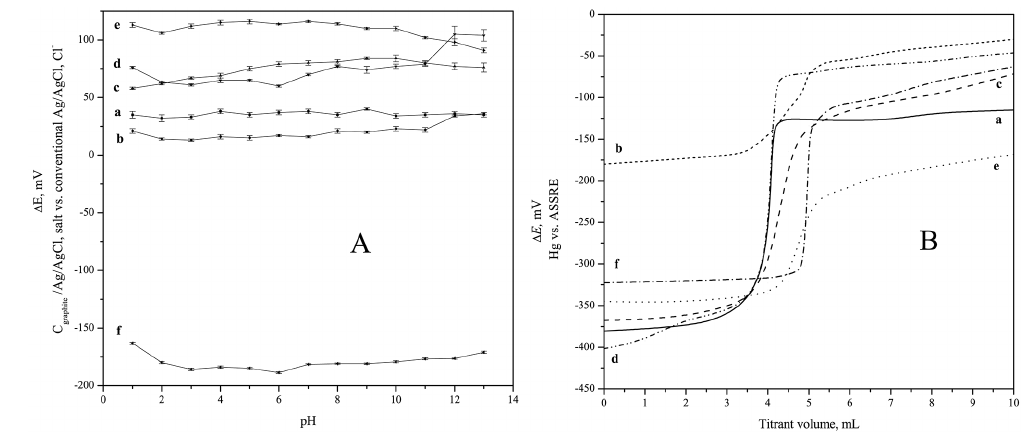
Figure 3. Influence of the pH and reducing agent on ASSREs. (A) Curves of pH obtained against ASSREs containing the salts (a) KCl, (b) KCl:SiO 2 , (c) BaCl 2 , (d) NaF, (e) Na 2 SO 4 , and (f) KI. (B) Curves of potentiometric titration of L-ascorbic acid using indicator electrode of mercury against ASSREs. Titrant: 0.0125molL − 1 copper (II) sulfate solution. Conditions and results: salts in ASSRE, mass of L-ascorbic acid titrated (in parenthesis), volume of titrant in the end-point and L-ascorbic acid content (% w/w ) found (in brackets). (a) KCl (9.1mg) 4.102mL [99%], (b) KCl : SiO 2 (10.6mg) 4.911mL [102%], (c) BaCl 2 (10.1mg) 4.484mL [98%], (d) NaF (9.2mg) 4.136mL [99%], (e) Na 2 SO 4 (11.0mg) 4.800mL [96%], (f) KI (10.3mg) 4.901mL [105%]. The measurements were taken at room temperature.